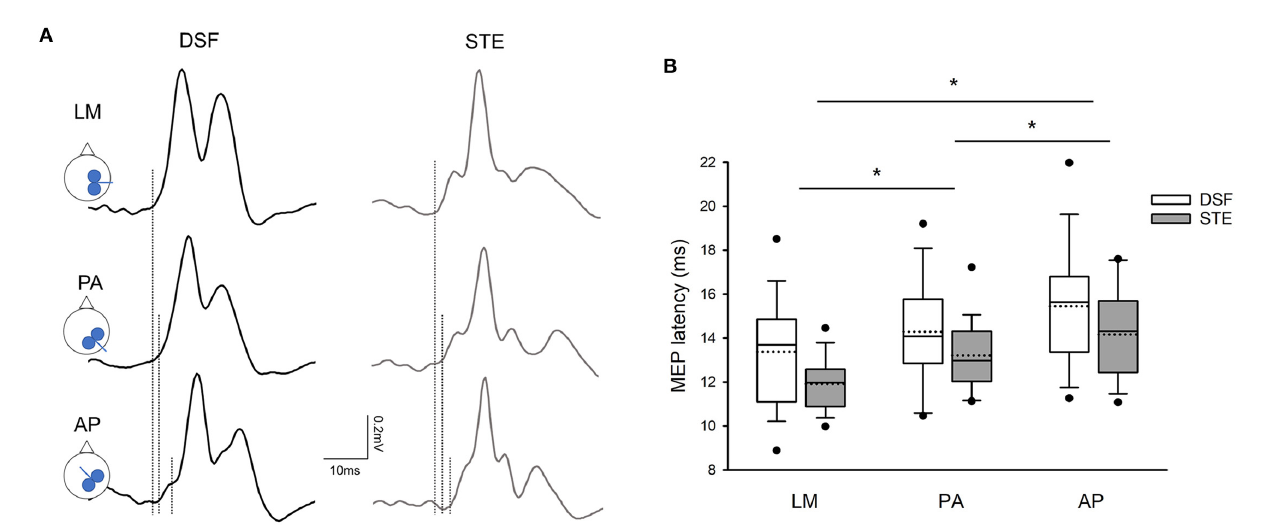
FIGURE2 MEP latencies. (A) Averaged MEPs from 15 rectified EMG traces in the contralateral erector spinae (ES) elicited by different coil orientations during the dynamic shoulder flexion (DSF) task and during the static trunk extension (STE) task in a representative participant. Note that the latency of ES MEPs elicited by the AP current direction was the longest, followed by the PA and LM current directions in both DSF and STE tasks. (B) Group mean data ( n = 20) demonstrating the onset latencies of ES MEPs with all current direction. Solid lines indicate median values; dotted lines indicate mean values. The box is interquartile range; error bars denote maximum and minimum values. * p < 0.05 between coil